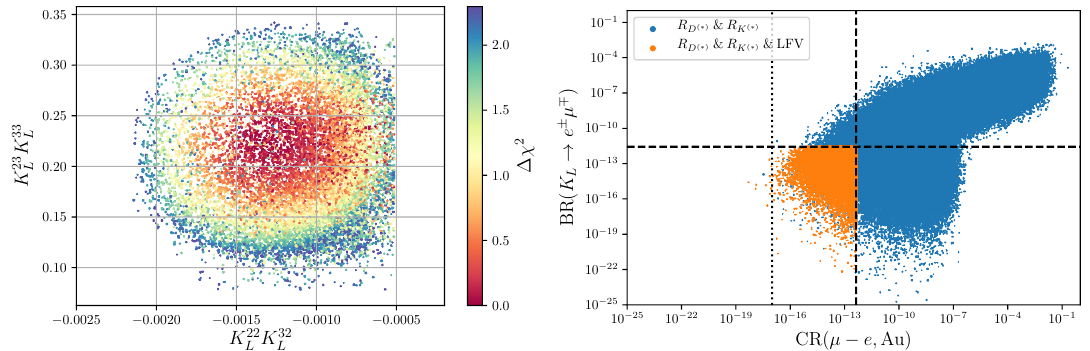
Figure 6 . On the left, (cid:1) (cid:31) 2 distribution for the (cid:12)t to R ( K L ) ij couplings. All points comply with the di(cid:11)erent ((cid:13)avour) constraints. On the right, regions in the plane spanned by CR( (cid:22) (cid:0) e ,N) and BR( K L ! (cid:22) (cid:6) e (cid:7) ), accommodating both R (blue) and those in addition complying with LFV constraints (yellow). Both panels correspond to a heavy sector composed of three isodoublet vector-like charged lepton states , and to having set m V (cid:24) 1 : 5 TeV. The (cid:1) (cid:31) 2 corresponds to the 1 (cid:27) -region around the best (cid:12)t point.